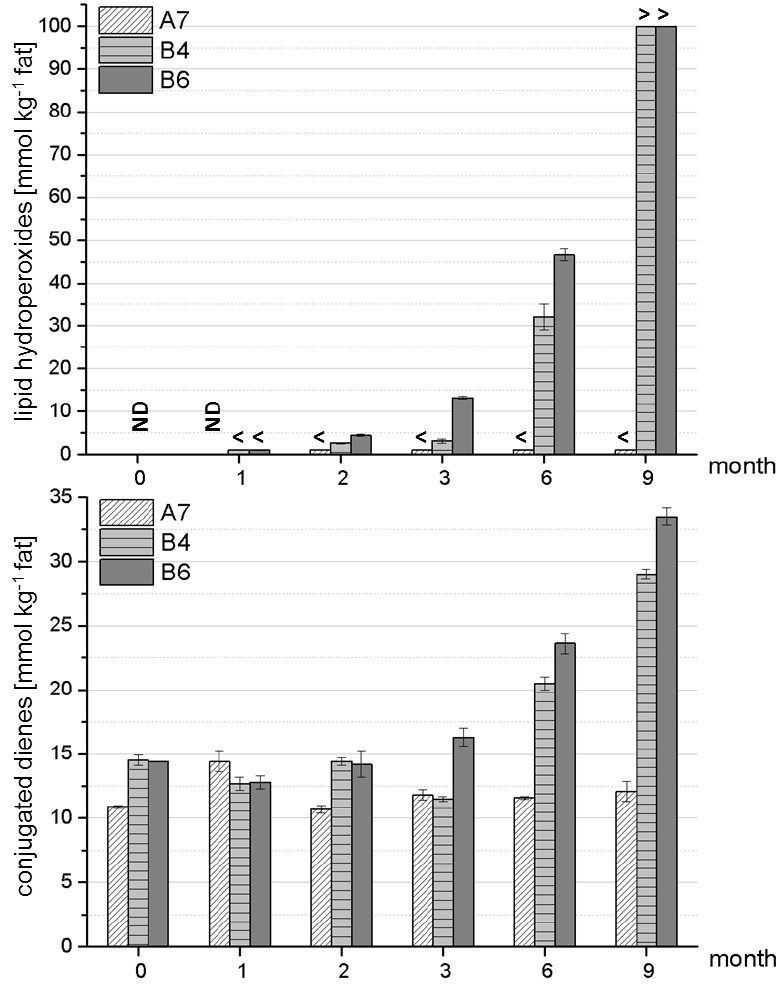
Figure 3. Example of a stable formulation (A7) compared to two less stable formulations (B4, B6) with respect to lipid autoxidation/formation of primary lipid oxidation markers. Analyses were performed in triplicate on two independent reconstitutions of powdered formulas. ND—not detected (below LOD); < below LOQ; > upper LOQ